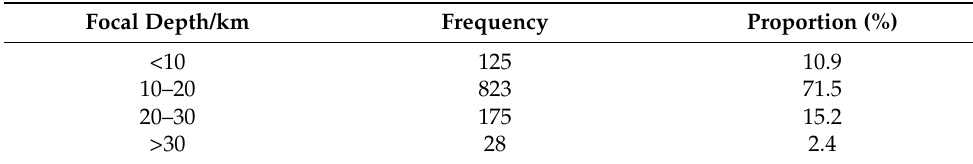
Figure 13. The distribution of earthquakes of Ms ≥ 2.0 in the study area from 1970 and the isostatic additional force relationships. The color scale indicates the isostatic additional force, the size of the gray dots indicates the earthquake magnitude, and the color shade indicates the focal depth. Abbreviations are the same as those used in Figure 1. Table 1. Focal depth of the Ms ≥ 2.0 earthquakes from 1970 to 2022.